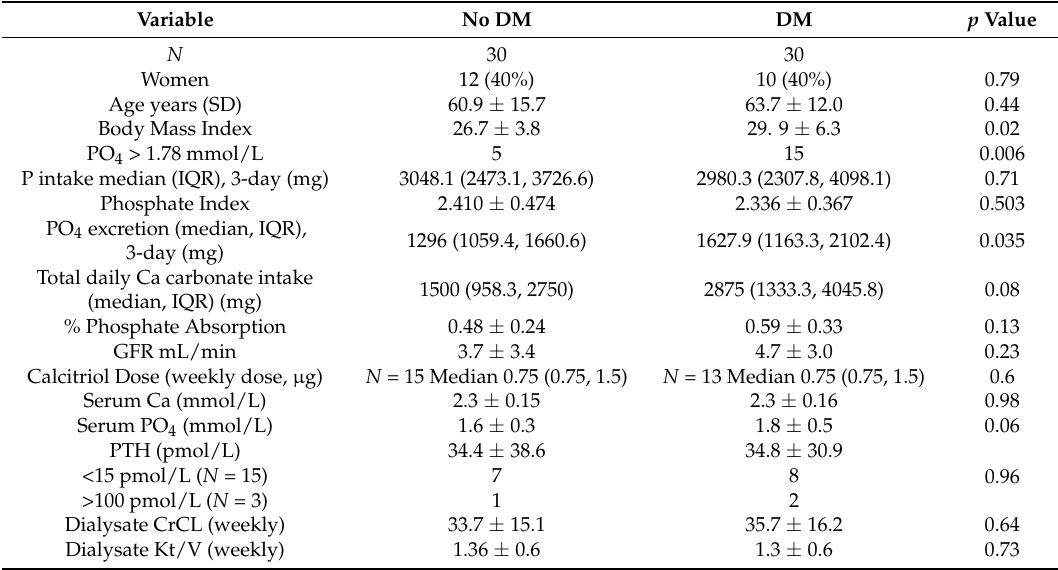
Table 4. Post-hoc analysis of differences between patients with and without diabetes